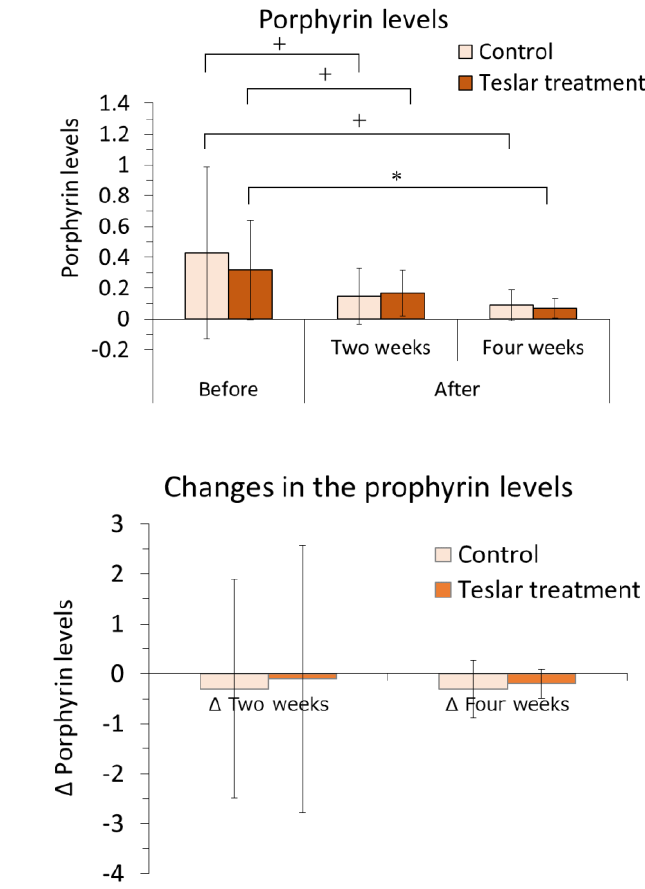
Figure 3. Cheek porphyrin levels and changes in the cheek porphyrin levels—Controls vs. Teslar treatments. ( a ) Cheek porphyrin levels and ( b ) changes in the cheek porphyrin levels. The results are expressed as the mean ± standard deviation of twelve experiments. * p < 0.05, + p < 0.1